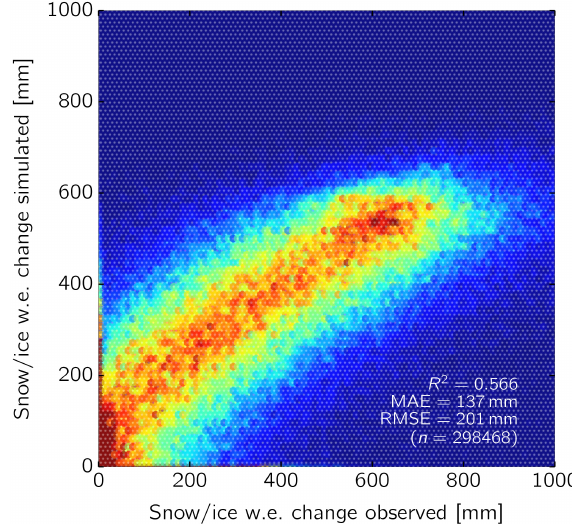
Figure 13. Observed (dashed) and simulated (solid) specific mass balance for Hintereisferner (HEF, top), Kesselwandferner (KWF, center), and Vernagtferner (VF, bottom) in the period 1997/1998– 2012/2013.